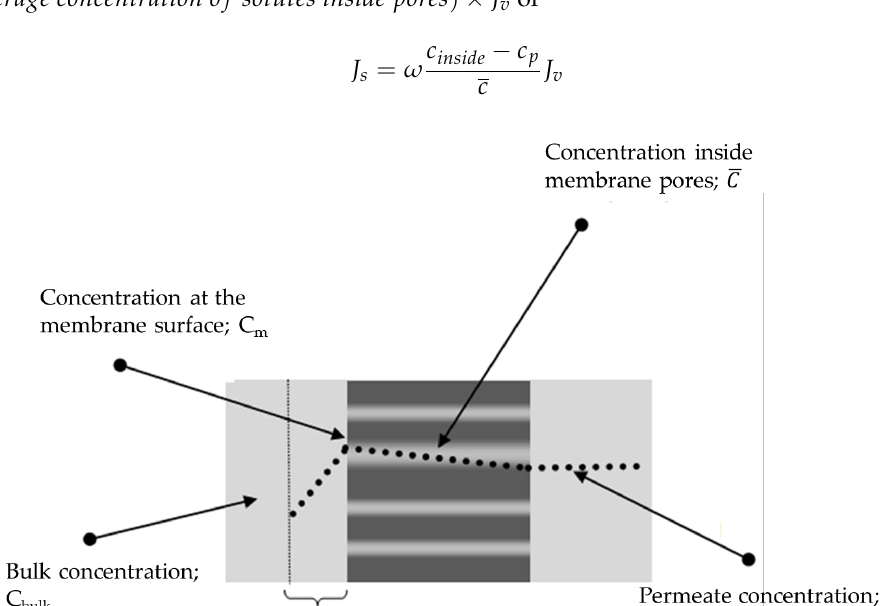
Figure 8. Concentration profile across the membrane.